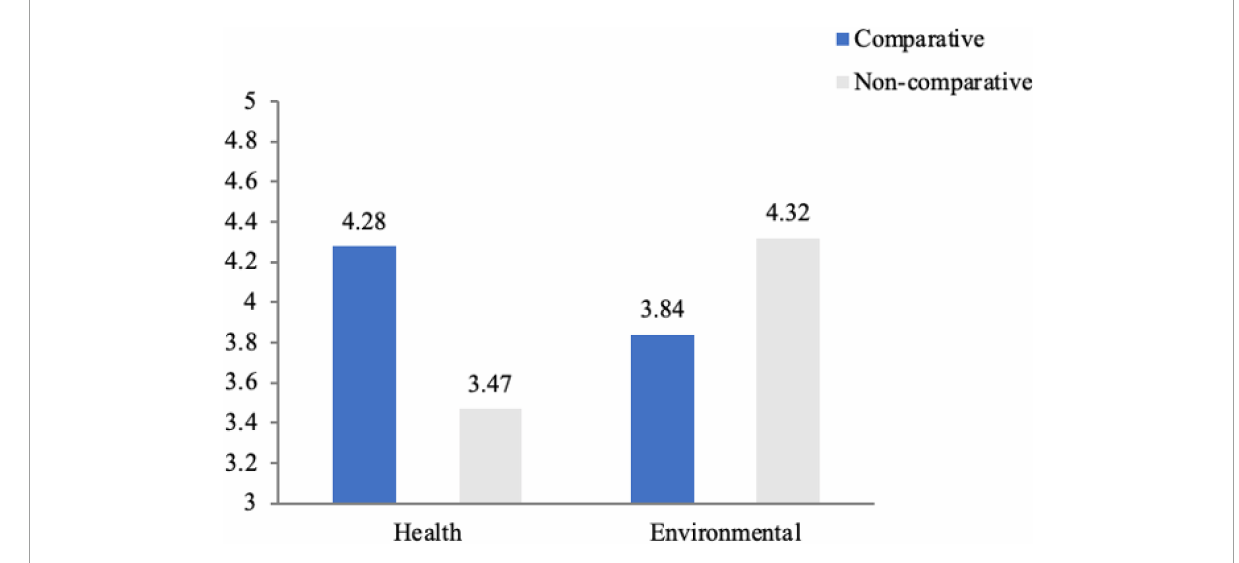
FIGURE2 Interaction effect between CA claims and benefit appeals on willingness to pay a